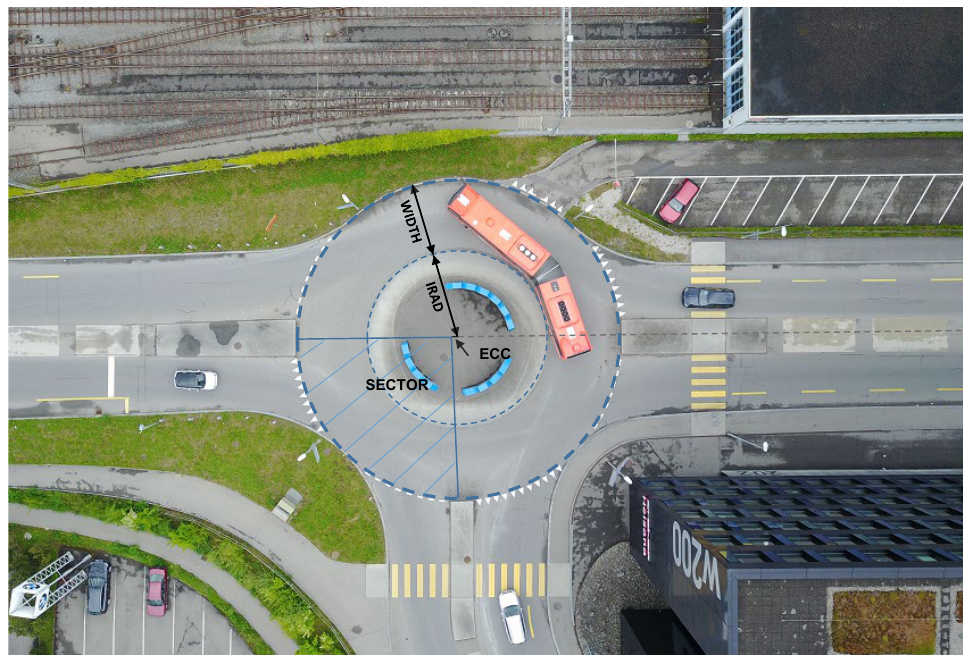
Figure 1. Roundabout geometry attributes: radius of the central island [IRAD], width of the circulatory roadway [WIDTH], eccentricity of the leg’s axis [ECC] and sector as defined by the intersection of two adjacent legs’